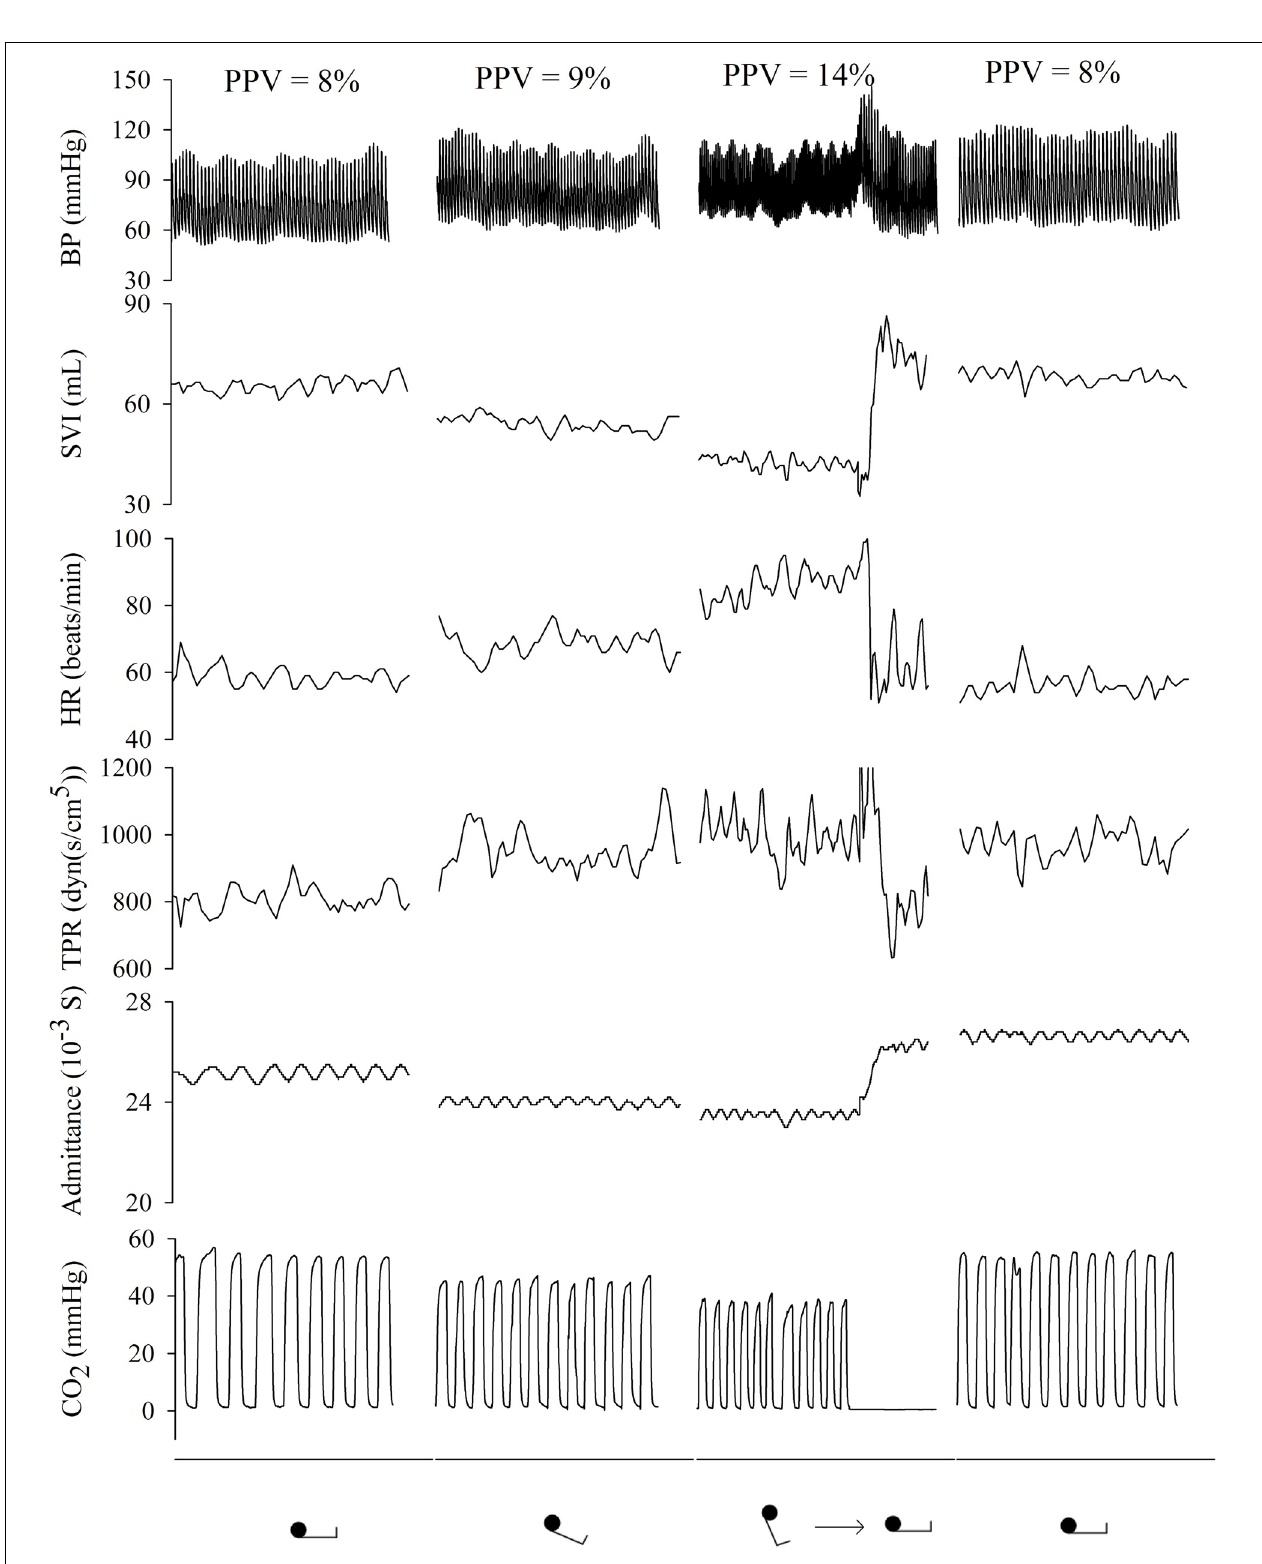
FIGURE 3 | Representative example (subject 11) of hemodynamic response to graded HUT and tilt back. BP, blood pressure; SVI, stroke volume index; HR, heart rate; TPR, total peripheral resistance; PPV, pulse pressure variation.